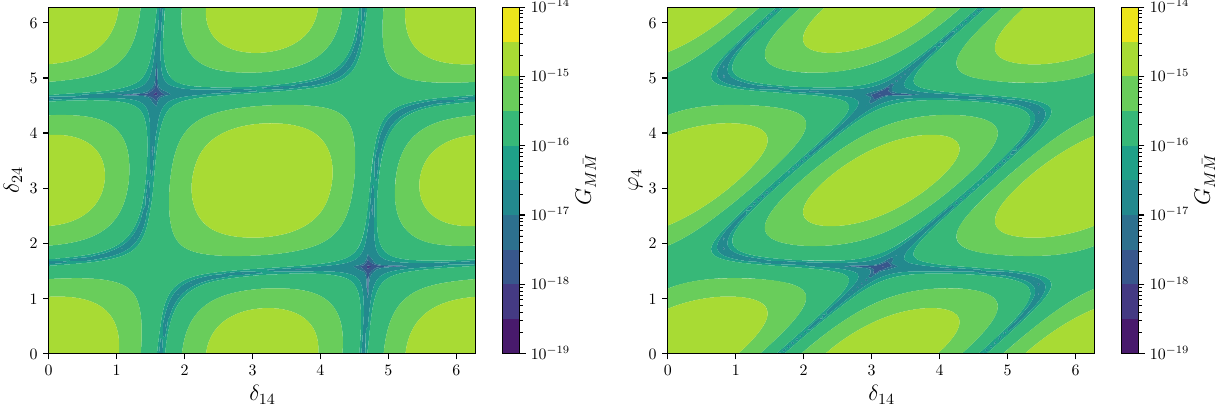
Fig. 10 Contour plots for the effective coupling G of Mu − Mu oscillations, for fixed values of the degenerate heavy sterile mass, m 4 = m 5 = MM 1 TeV, with θ 1 j = 10 − 3 , θ 2 j = 0 . 01 and varying pairs of CPV phases: (δ 14 − δ 24 ) and (δ 14 − ϕ 4 ) , respectively in the left and right panels. Colour code as in Fig.